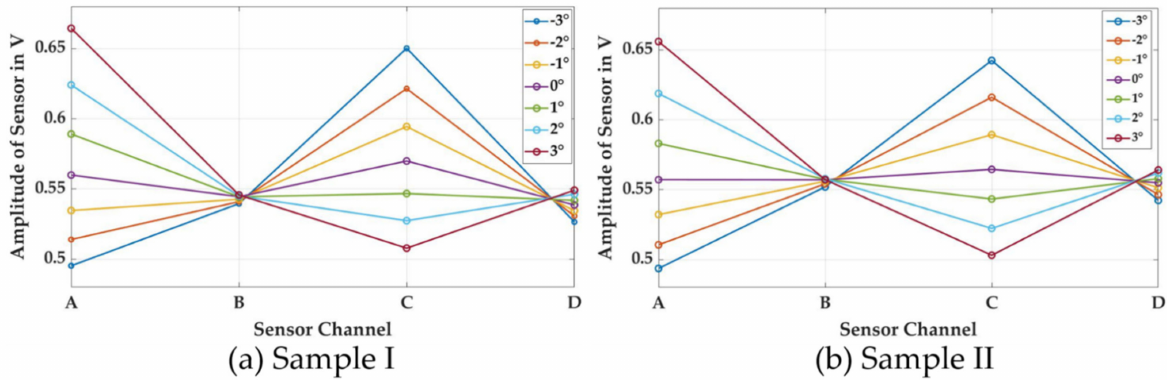
Figure 7. Effect of tilting on sensor readings in regards to the individual sensor channels for the cases of ( a ) strong anisotropy and ( b ) weak anisotropy.